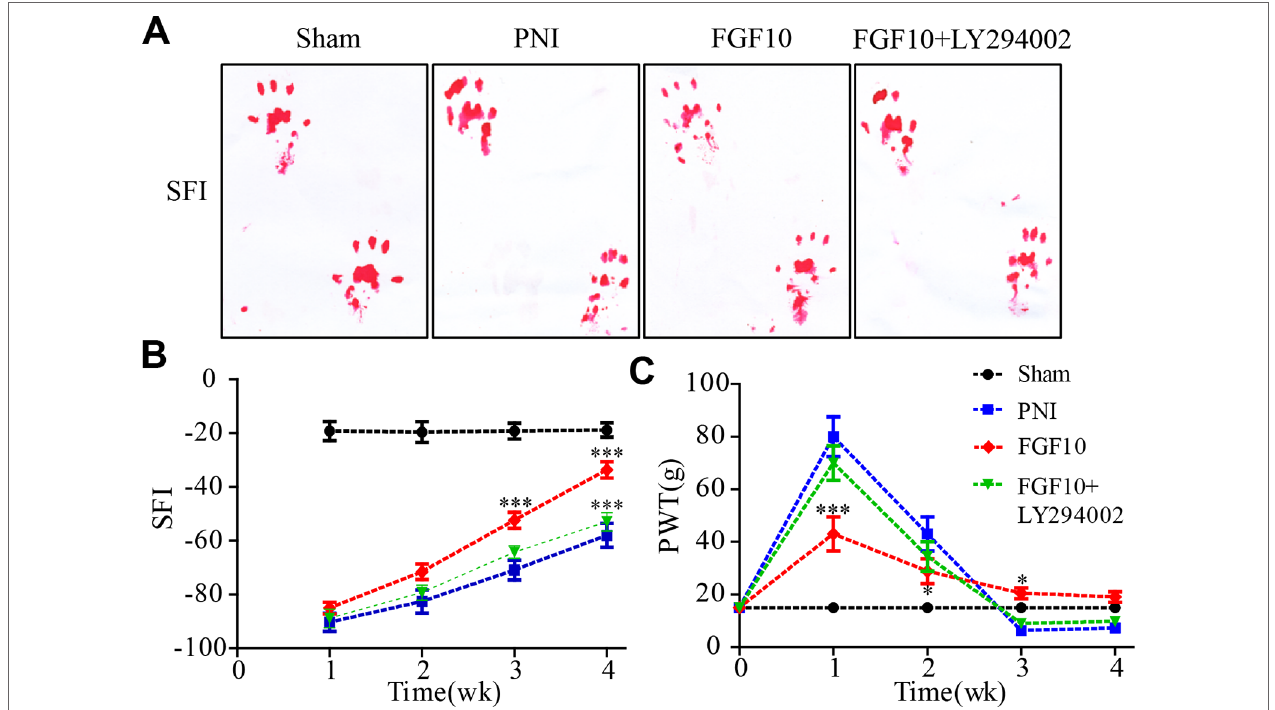
FIGURE 1 | Fibroblast growth factor 10 (FGF10) enhances motor and sensory functional recovery after peripheral nerve injury (PNI). (A) Photographs of rat footprints 4 weeks after sciatic nerve crush. (B) Statistical analysis of the sciatic functional index (SFI) at the indicated times postoperatively. (C) Paw mechanical withdrawal thresholds were measured at predetermined time points. FGF10 group vs PNI group: * P < 0.05, *** P < 0.001. FGF10 group vs FGF10+ LY294002 group: *** P < 0.001. All data represent the mean values ± SEM; n = 8 in each